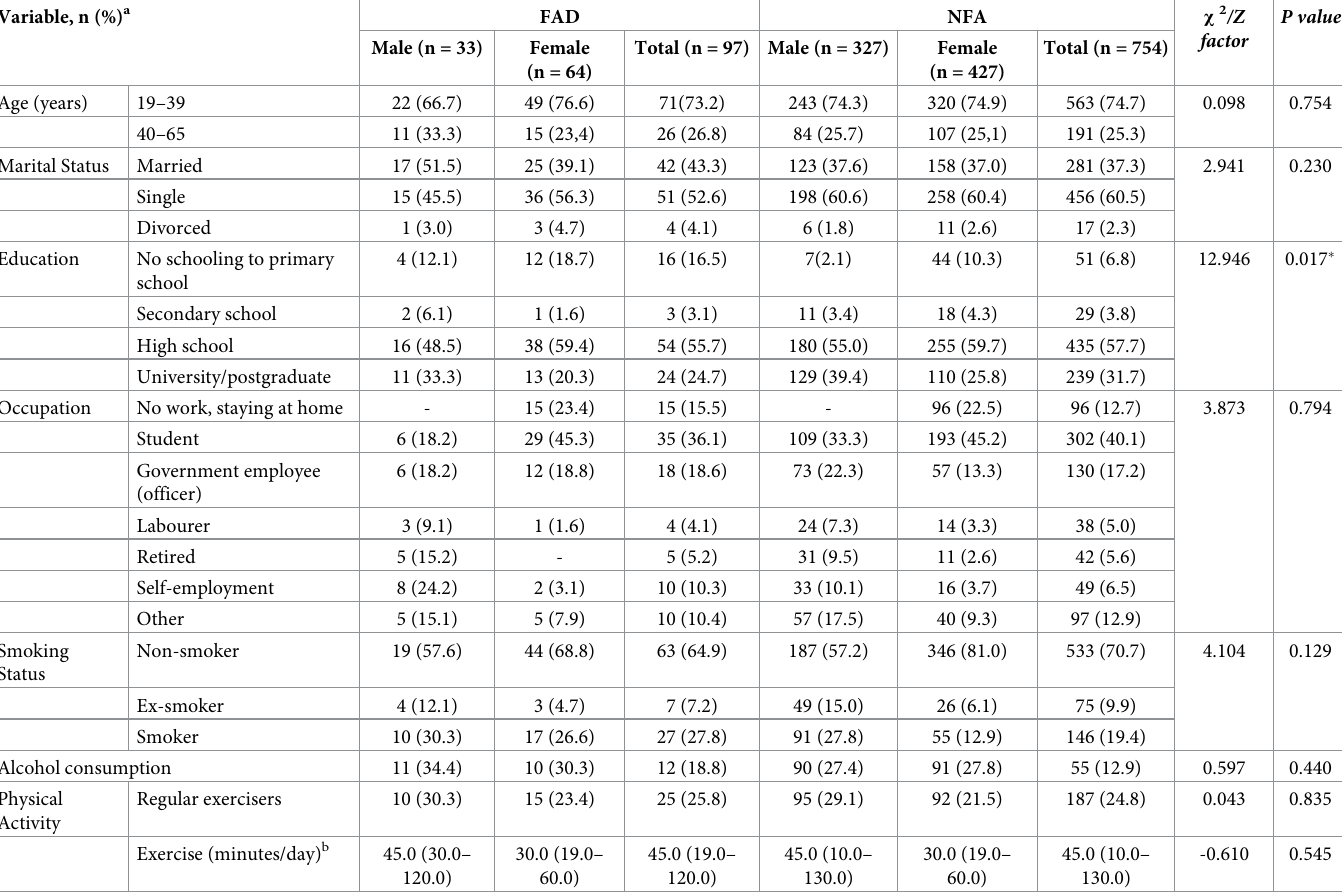
Table 1. General characteristics of the participants categorized by presence of food addiction by